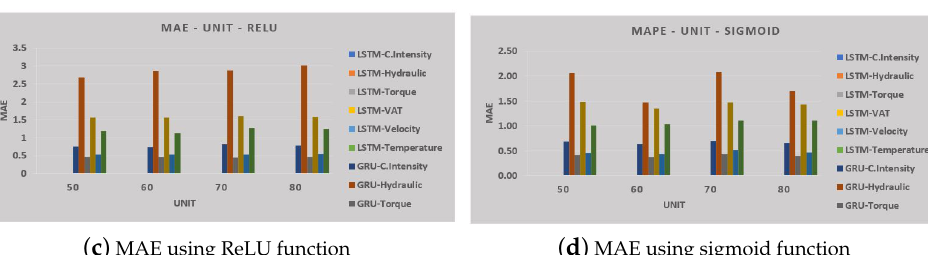
lowest RMSE error with 50 units in the hidden layer. Experiments described in Section 6.3